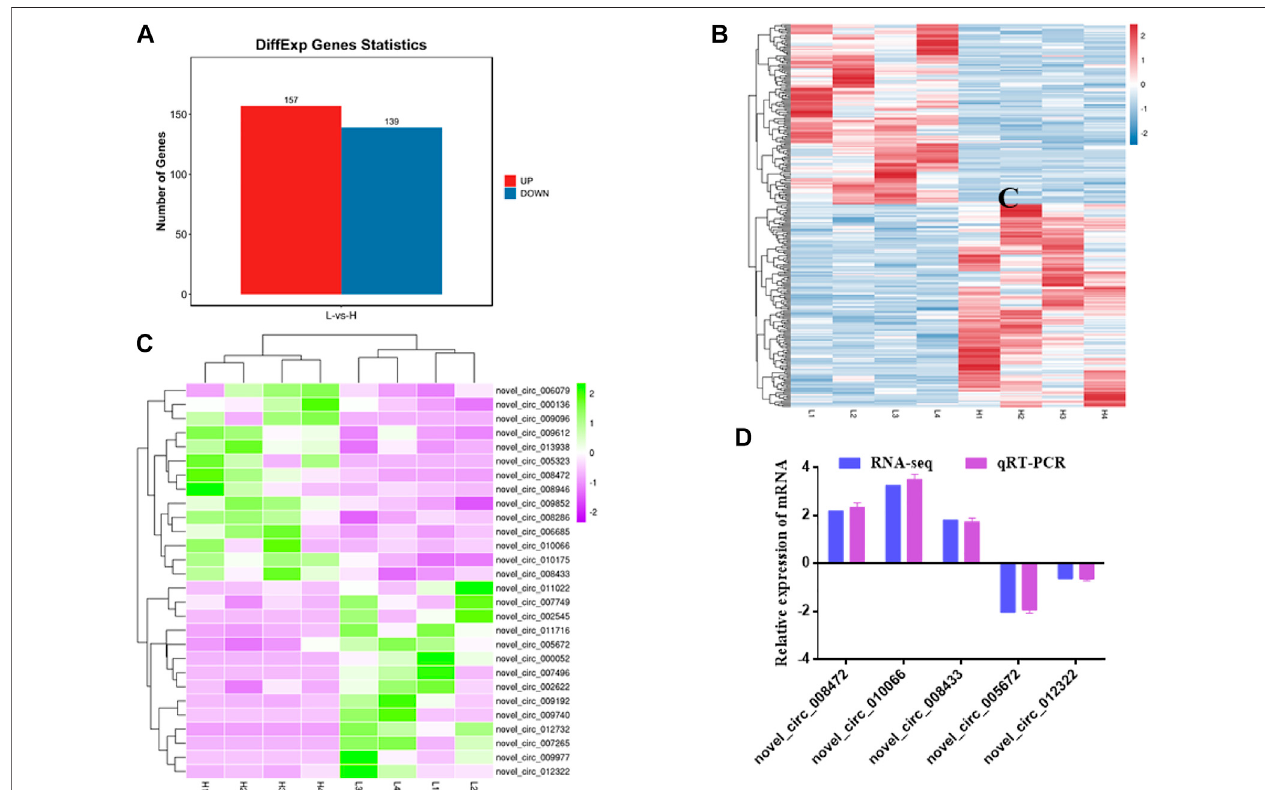
FIGURE 4 | Statistics and heat map analyses of DE circRNAs. (A) Statistics of DE circRNAs. Red represents up-regulation, blue represents down-regulation. (B) Heat map analysis of DE circRNAs. Each column represents a sample and each row represents a circRNA. Red and blue gradients indicate increase and decrease in gene expression abundance, respectively. (C) Heat map analysis of DE circRNAs related to skeletal muscle development. Each column represents a sample and each row represents acircRNA. Purpleand green gradients indicate increase and decrease in gene expression abundance, respectively. (D) Validation of DEcircRNAs. Blue represents RNA-seq result, purple represents qRT-PCR